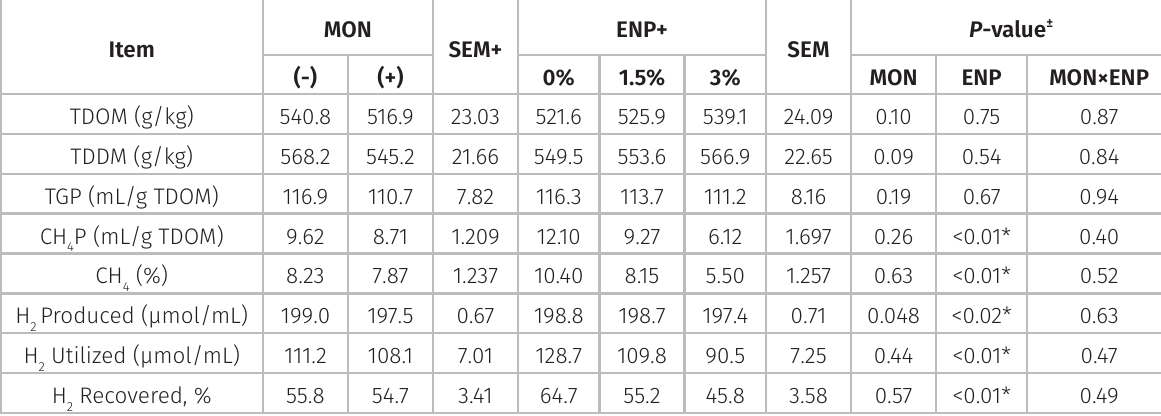
Table III. Effect of inclusion encapsulated nitrate product (ENP) in diets without (-) or with (+) monensin (MON) on the truly degraded organic matter (TDOM), truly degraded dry matter (TDDM), total gas production (TGP), methane production (CH P) and 4